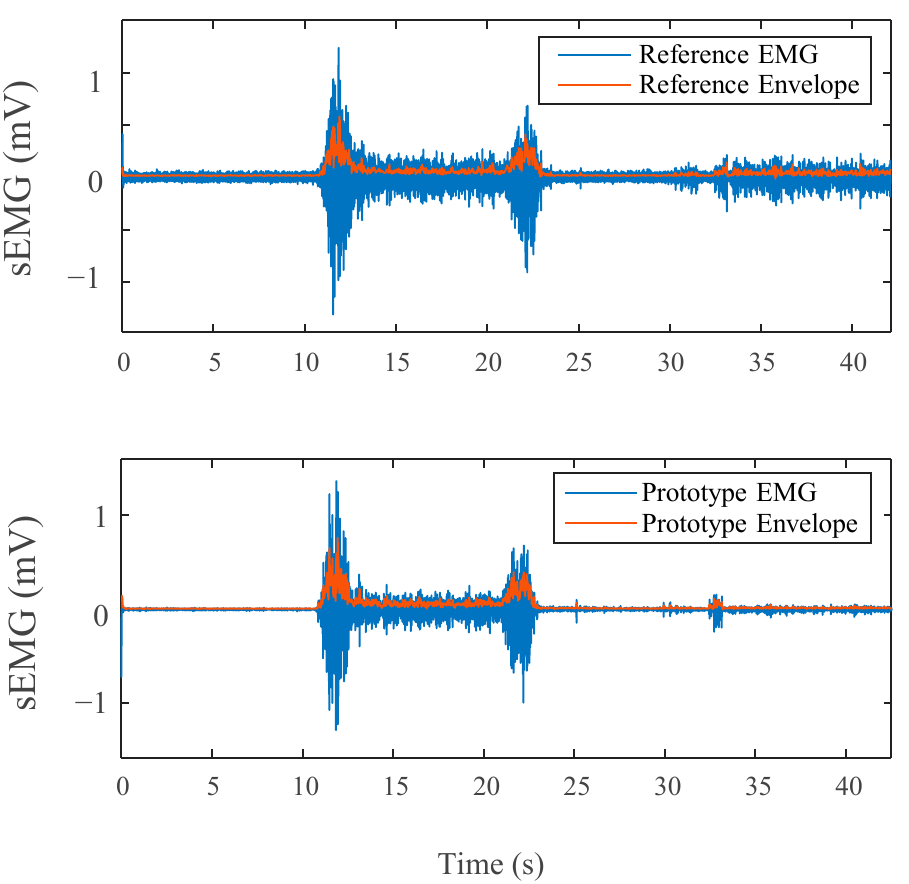
Figure 7. Side by Side comparison of EMG for both devices on one contraction, Envelope in Red.